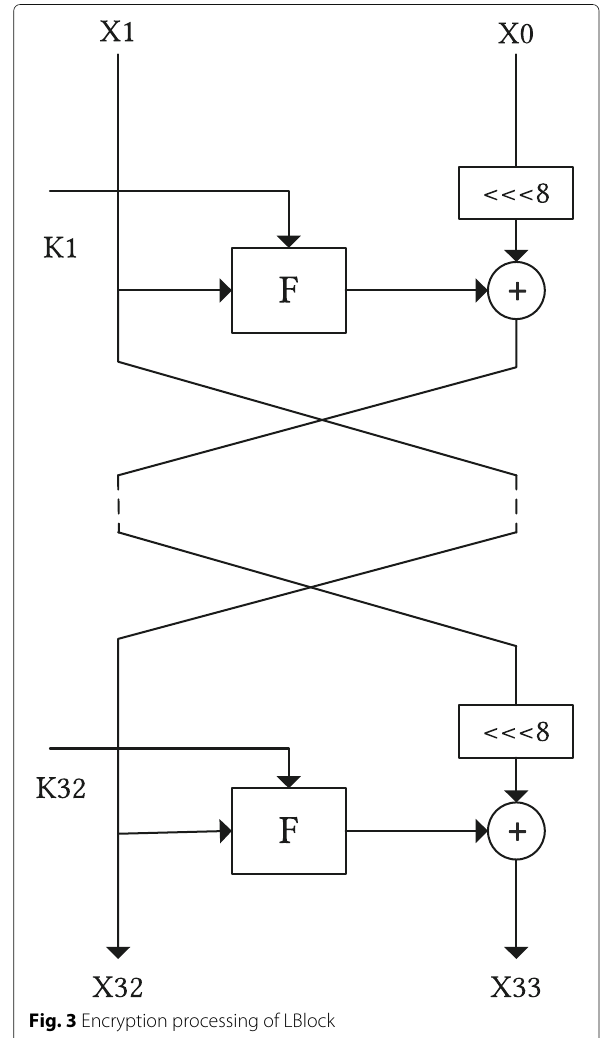
rounds of data processing, the 32-bit binary strings can be obtained through the equation X i = F ( X i − 1 , K i − 1 ) ⊕ ≪ 8 ) , i ∈ [ 2, 33], where F is the round func- ( X i − 2 tion which is illustrated in Fig. 4, K i − 1 represents the 32-bit round subkey in each round encryption, and the operation ≪ represents the 8-bit left cyclic shift. In the round function F , in order to achieve the balance between enough security margin and efficient implemen- tation, eight minimized 4-bit S-boxes is shown in Table 3 in which a 4-bit word-wise permutation are used. As shown in Fig. 3, only half of the data are selected to pass through the round function in each round and the other half of the data just use the operation of simply rota- tion. The key scheduling of LBlock is designed in the way of a stream cipher. Firstly, the round subkey K1 is the output of the leftmost 32 bits of the 80-bit master key K = k 79 k 78 k 77 k 76 . . . k 1 k 0 . Then, for i = 1, 2, . . . ,